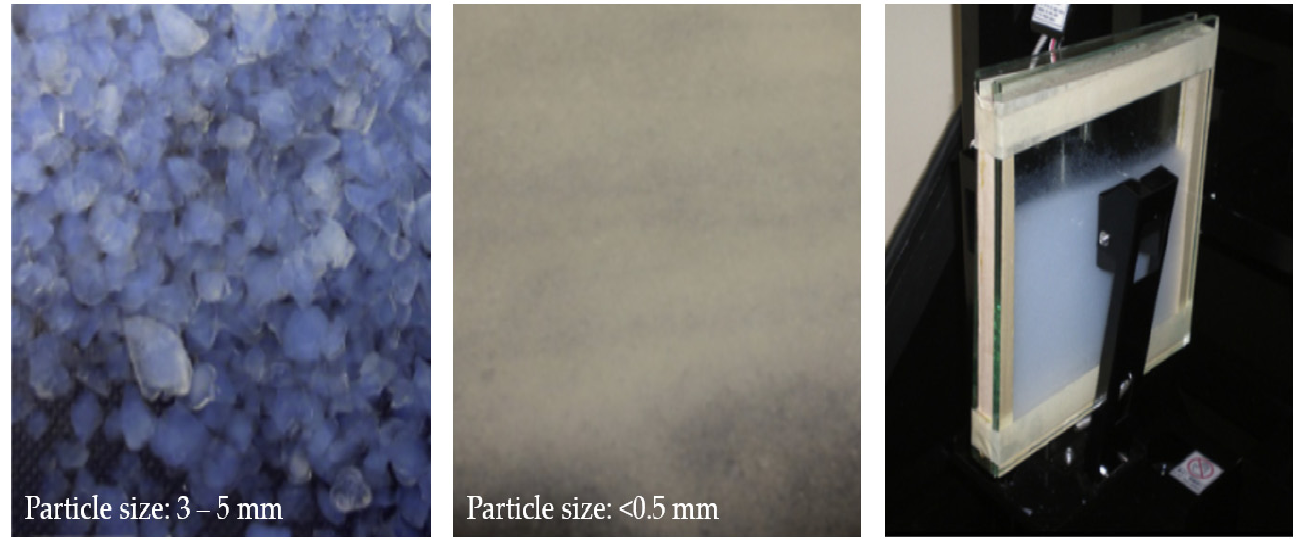
Figure 6. Silica aerogel granules used in glazing units [23,39].